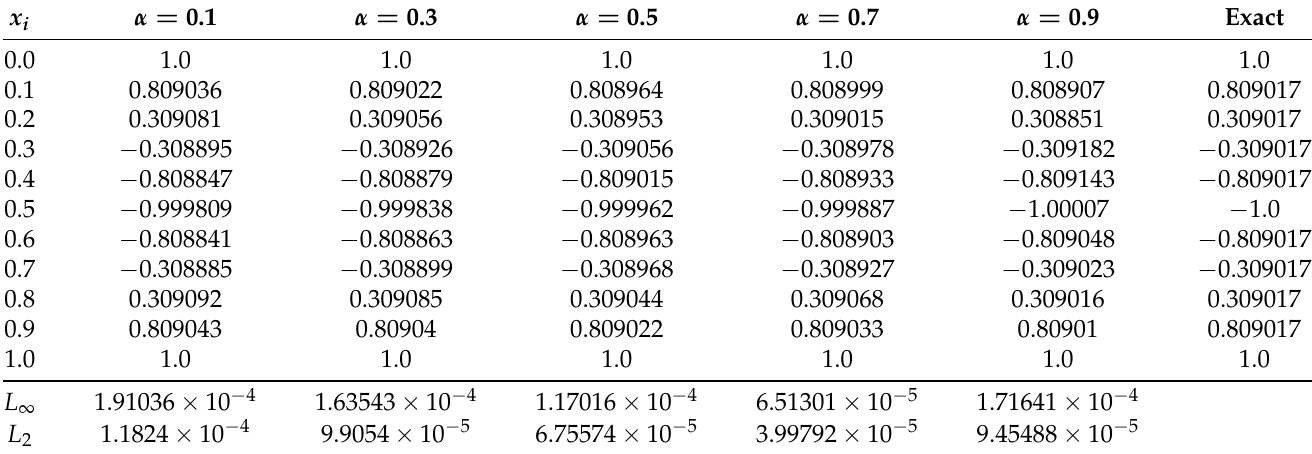
Table 3. Error norms, numerical solutions and comparison of the exact solution of imaginary part of